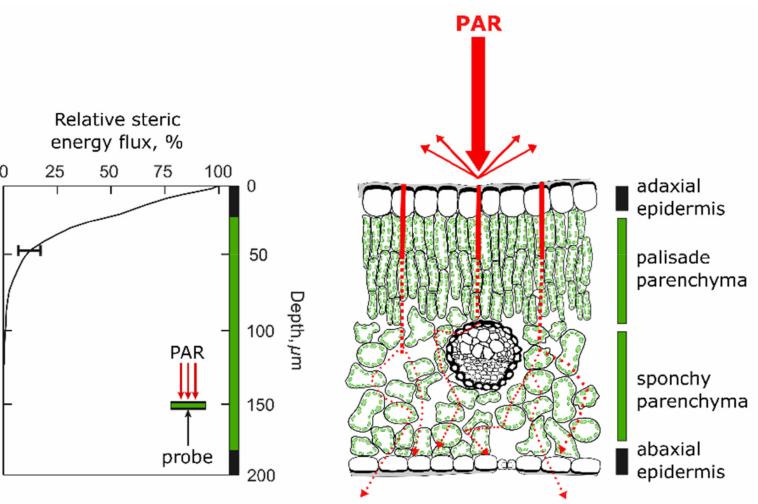
Figure 3. Gradient profile of blue light as relative steric energy flux, % of incident photosyntheti- cally active radiation (PAR), inside a bifacial leaf of Vitis vinifera and measured using a fibre optic microprobe. The leaf was irradiated with collimated light with the adaxial surface facing the light. The probe was inserted from the abaxial leaf side and advanced directly through the leaf until reached the adaxial side, while recording the amount of light (curve in the left part of the figure). See [103] (Figure 3) for more details. (Right) Representation of a typical bifacial leaf. Red arrows show a conceptual representation of surface light reflectance, surface and mesophyll light scattering, and hypothesized light path lengthening. Red lines appear thinner along the depth representing light depletion. The vertical thick lines (left and right) give the thickness (depth) of the leaf (black epidermises; green: mesophyll tissues). Gradient light profile graph (left) is reproduced from